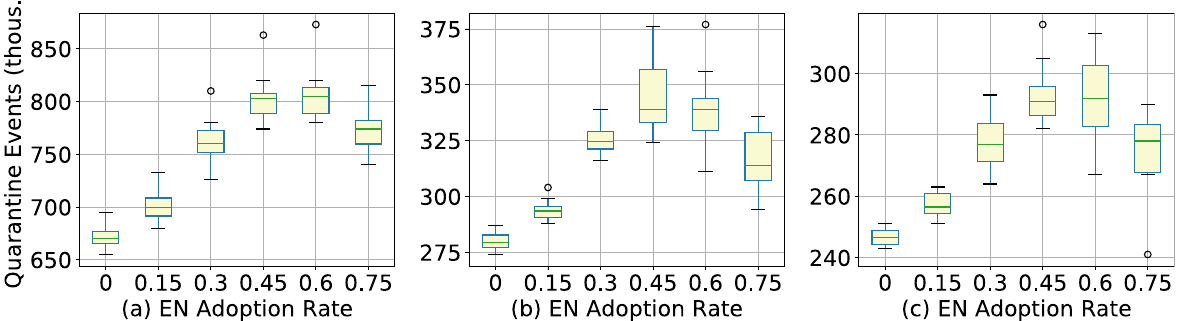
Fig. 3 Quarantine events vs exposure noti fi cation adoption. Estimated total quarantine events of King ( a ), Pierce ( b ), and Snohomish ( c ) counties for various levels of exposure noti fi cation app uptake among the population from July 11, 2020 to December 25, 2020. Note that even for the “ default ” (0% exposure noti fi cation app uptake) scenario there is a non-zero number of quarantine events because this assumes that symptomatic and con fi rmed COVID-19 positive individuals will self-quarantine at a rate of 80%, even in the absence of an app.